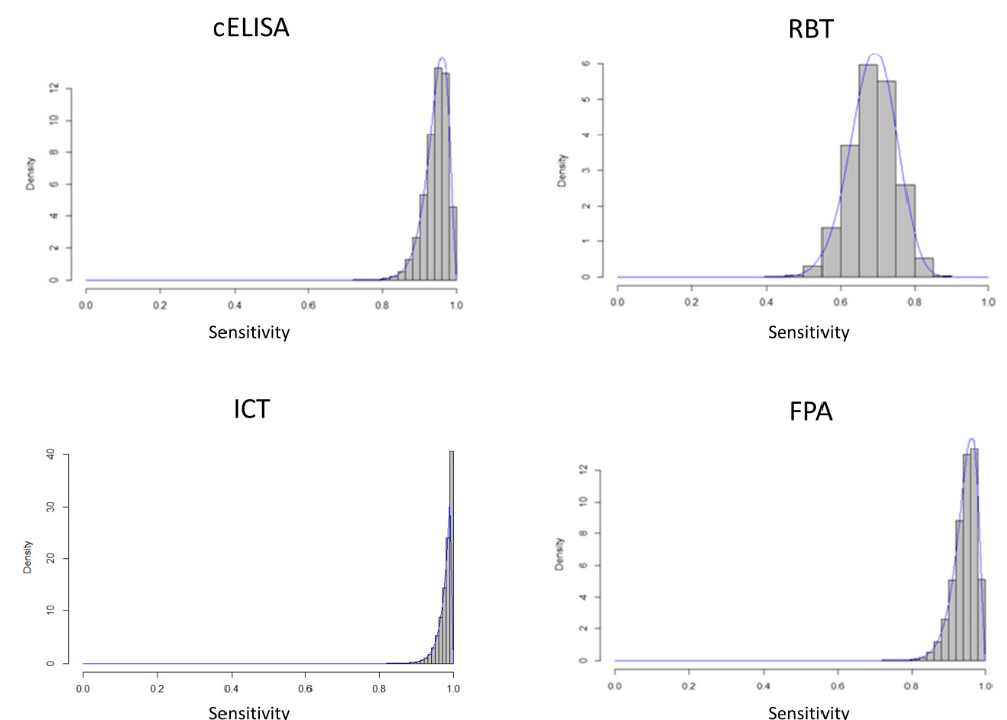
Figure 1. Estimated distributions of sensitivity values for c-ELISA, Rose Bengal Test (RBT), Immunochromatographic Test (ICT)and Fluorescence Poarization Assay (FPA).